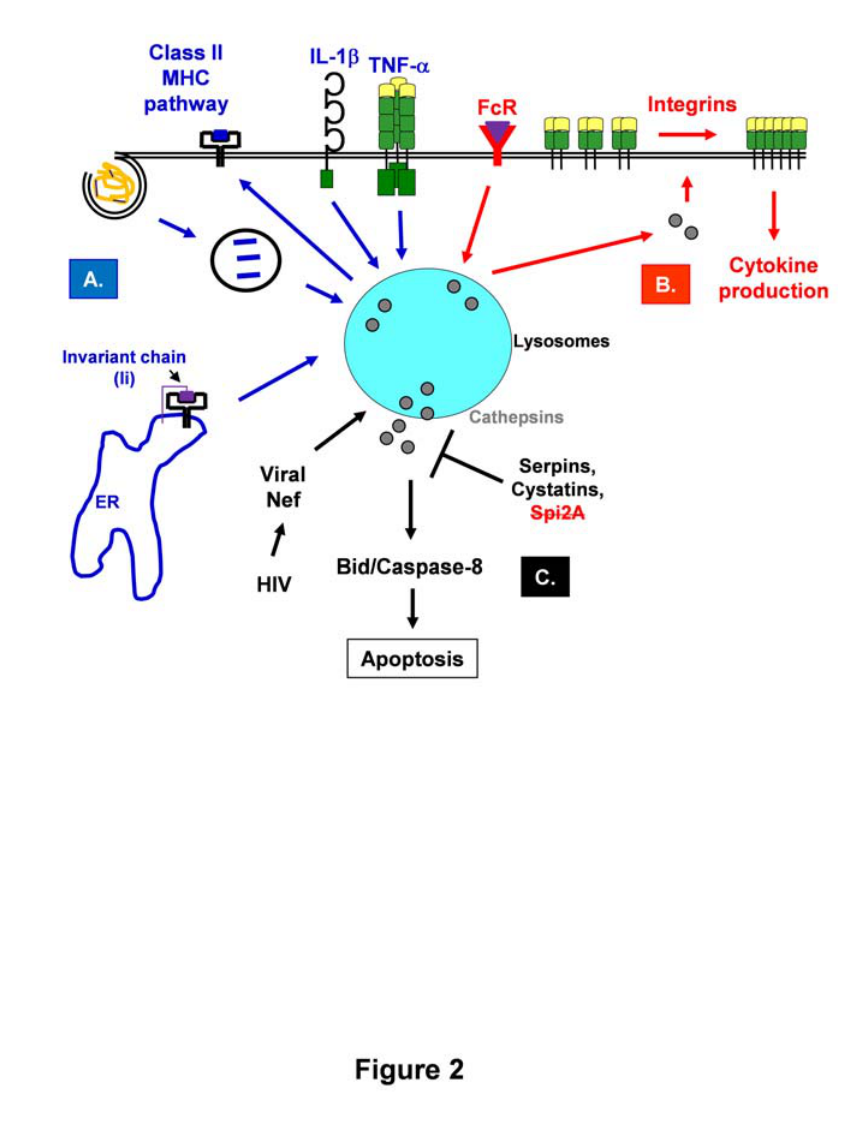
Roles of cathepsins in adaptive immunity. A. Lysosomal proteases remove the invariant chain (li) chaperone and introduce cleavages in endocytosed antigens which will consequently trigger unfolding and capture of processed antigen by newly synthesised class II MHC molecules. Moreover, cytokines (e.g. IL-1 β , TNF- α ) can modulate cathepsin activity and influence the class II MHC pathway. B. Activation of immune cells, for example following Fc receptors (FcR) ligation by immune complexes, induces conformational changes to surface receptors, such as β -integrins, increasing integrin affinity for its ligands. By an unexplained mechanism, cathepsins access the cytosol and target integrins at the plasma membrane. Both rearrangement of their cytoskeleton and ligand binding result in clustering of these molecules, thereby increasing cell-to-cell contact or adhesion to extracellular matrices. C. Following induction of apoptosis by different stimuli, such as the viral protein Nef, lysosomal cathepsins are released into the cytosol. Once in the cytosol, these proteases will induce the proteolysis of different targets (e.g. caspase-8, Bid, and anti-apoptotic Bcl-2 family members) and activate the enzymatic signalling cascade of apoptosis. In the cytosol, the cathepsin activity can be kept in check by the cysteine protease inhibitors, serpins, and